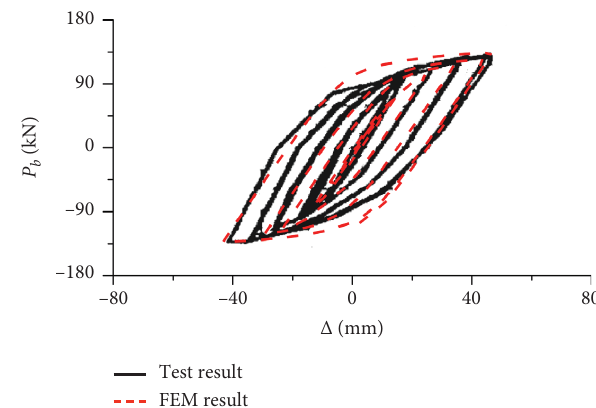
Figure 4: Comparison of the hysteretic